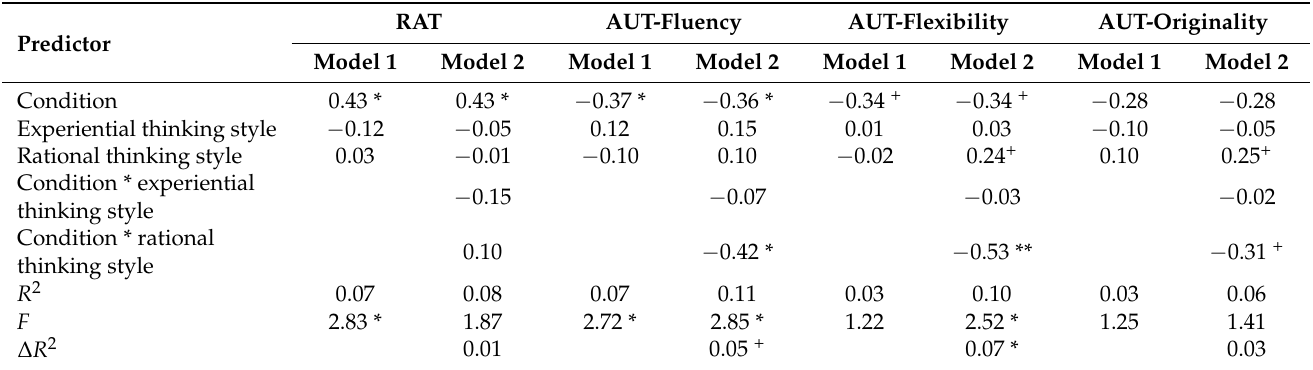
Table 2. Moderating effects of experiential and rational thinking